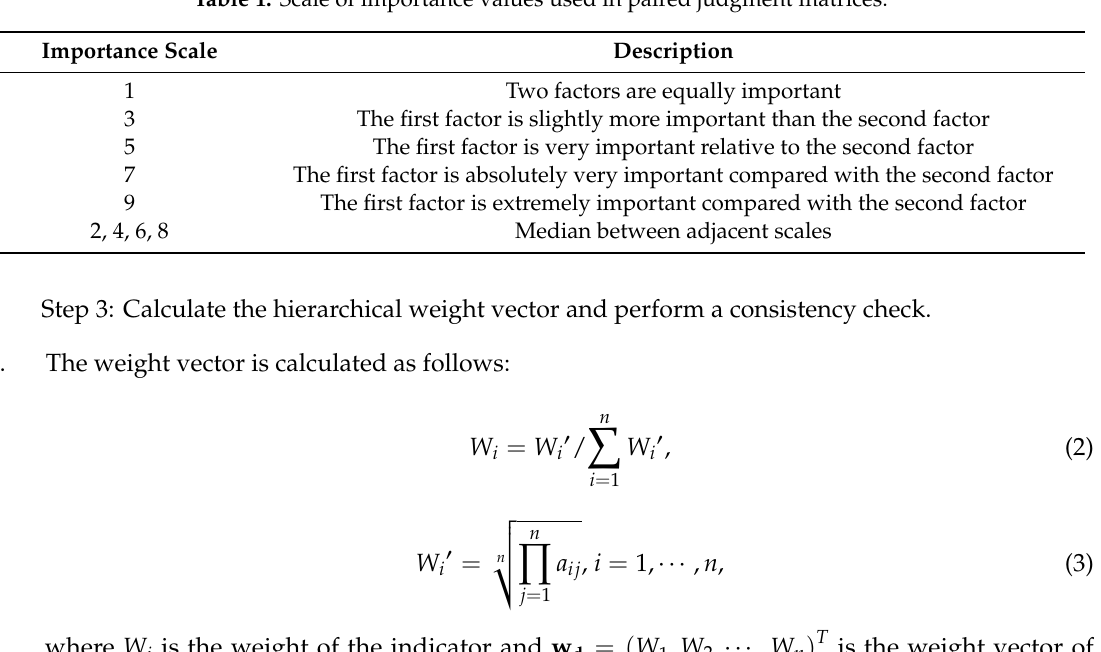
Table 1. Scale of importance values used in paired judgment matrices.